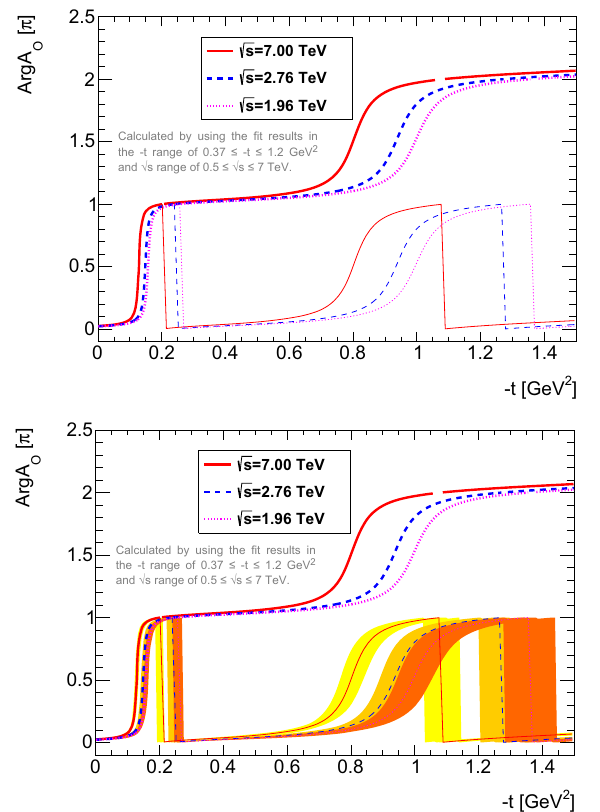
Fig. 25 Same as Fig. 21 but for the phase of the amplitude of Odderon exchange